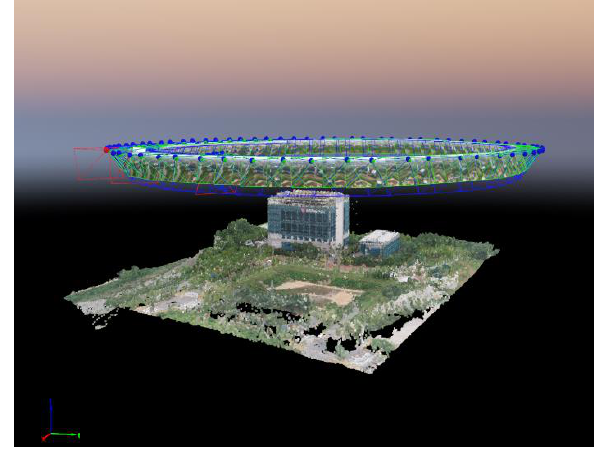
Figure 3 Oblique image photographing points and point cloud generation results.